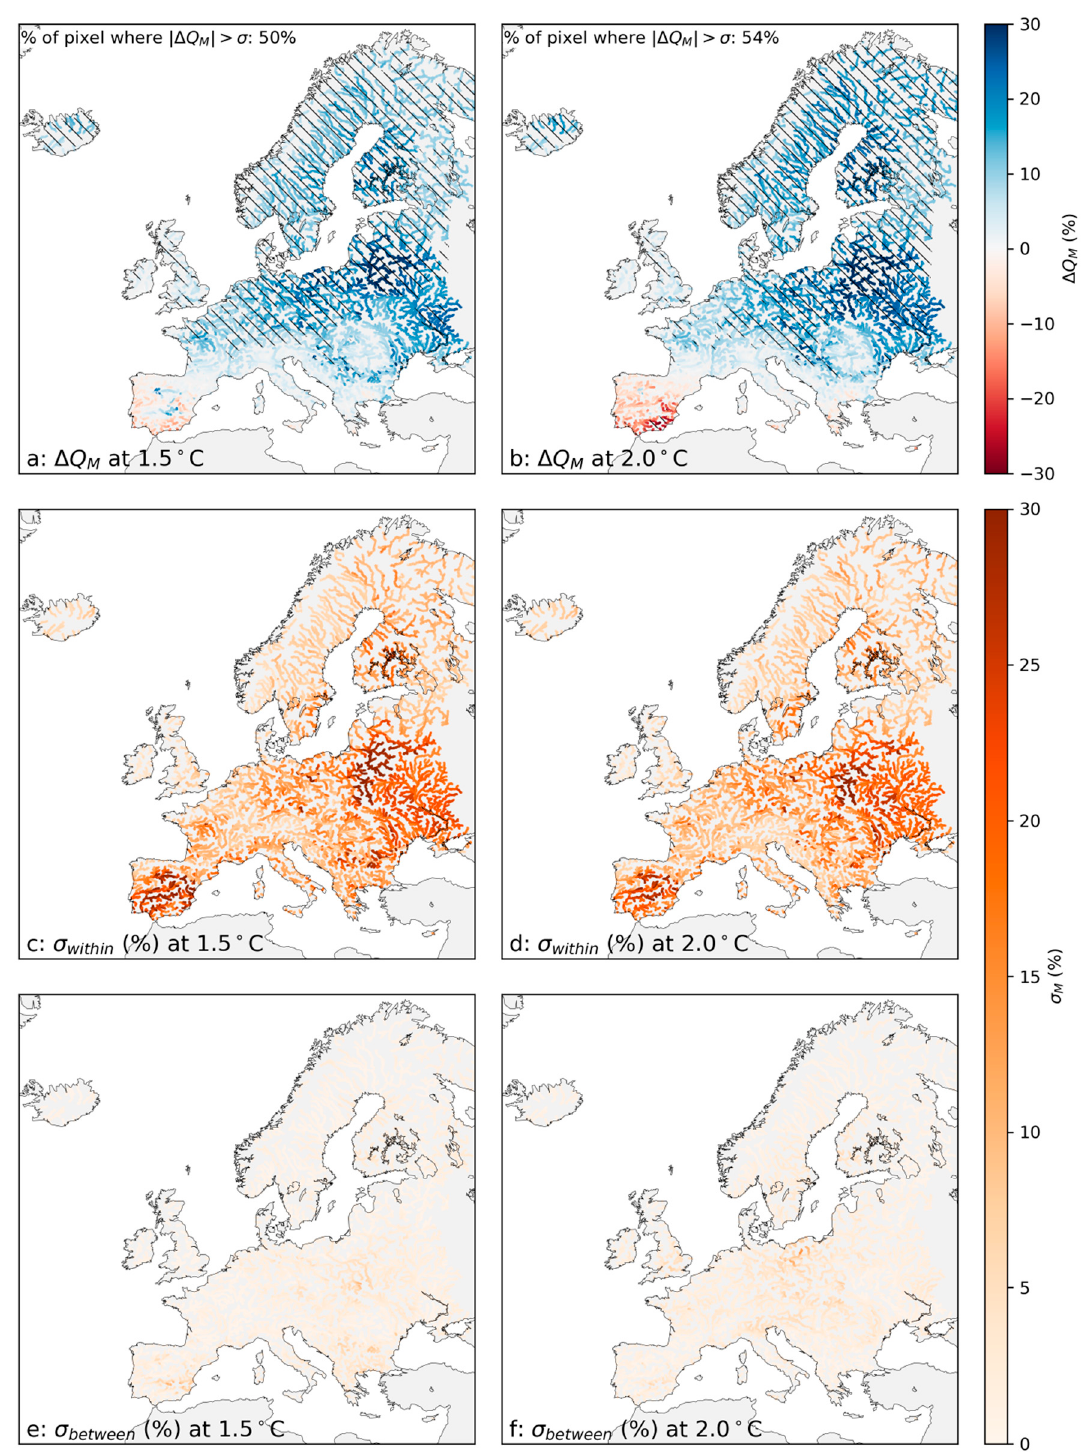
Figure 3. Same as in Figure 2 for the mean discharge ( Q M ).